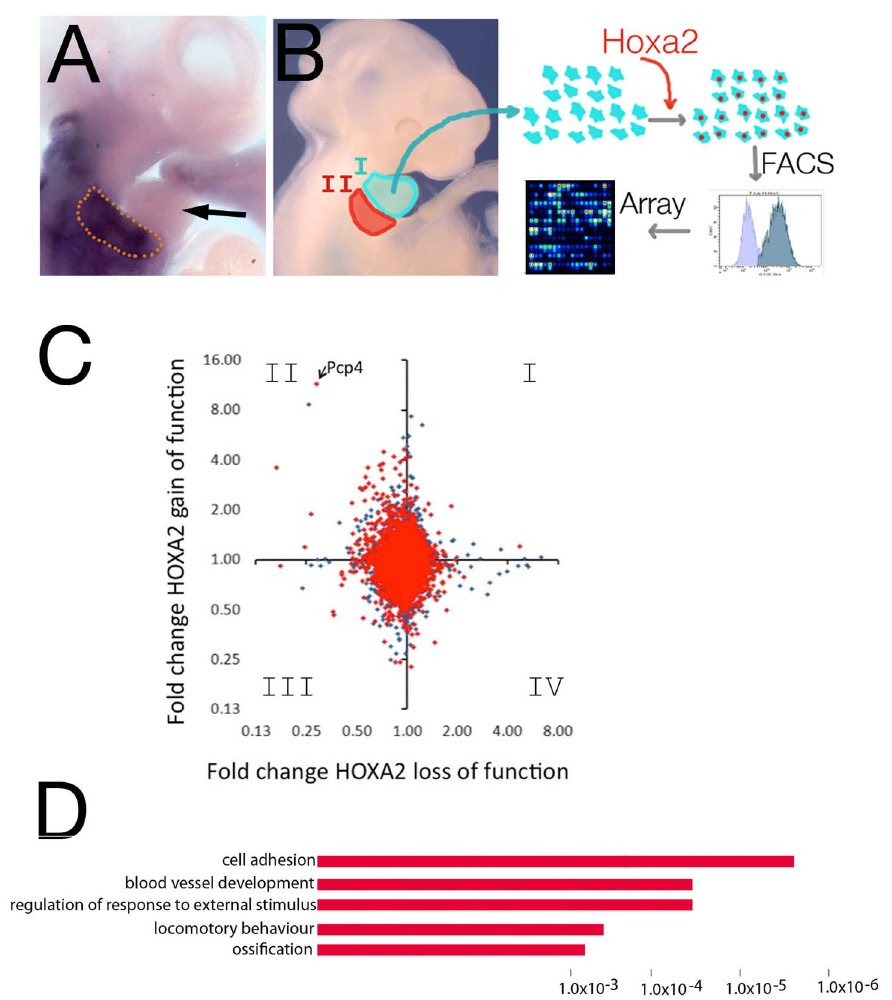
Figure 1. Hoxa2 gain of function in IBA cells. A, In situ hybridization using Hoxa2 probe shows Hoxa2 is mainly expressed in the IIBA (enclosed in the dotted line) and expression is excluded from the IBA (arrow). B, Schematic representation of the experiment: cells isolated from IBA are grown in vitro and transfected with Hoxa2-IRES-GFP (or GFP alone, control). RNA is extracted from GFP-positive cells and analyzed by microarray. C, Pairwise comparison of microarray experiments for Hoxa2 loss of function (x-axis) versus Hoxa2 gain of function (y-axis). Data are plotted as fold change against control in each case (axes in logarithmic scale base 2). Genes in red are nearby a Hoxa2-bound region in ChIP-seq (closest two genes to Hoxa2-bound region were included). D, Functional annotation of genes responsive to Hoxa2 gain of function only. The top over-represented categories are shown; the length of the bars corresponds to the P-values on the x-axis.